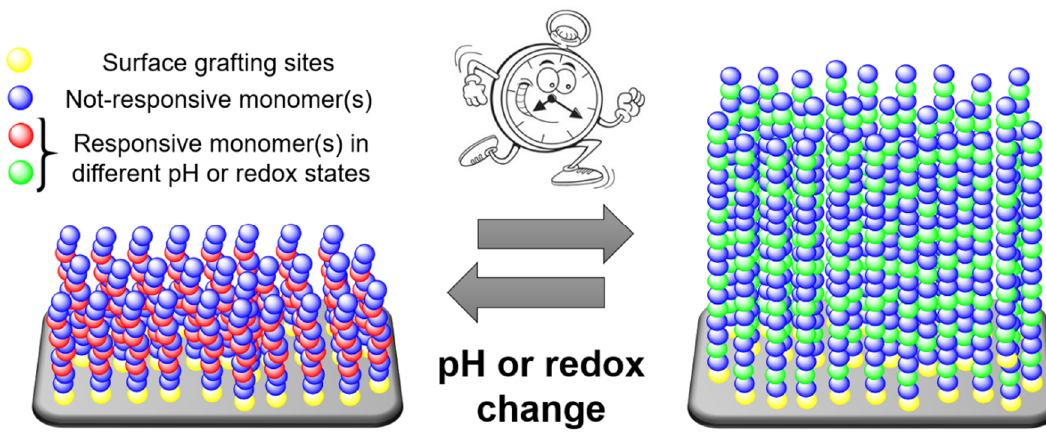
Figure 4. Schematic representation of self-oscillating polymer brushes, periodically swelling and collapsing in a closed homogeneous environment without the need for external stimuli, an autonomous behavior of great interest for biomimetic applications.